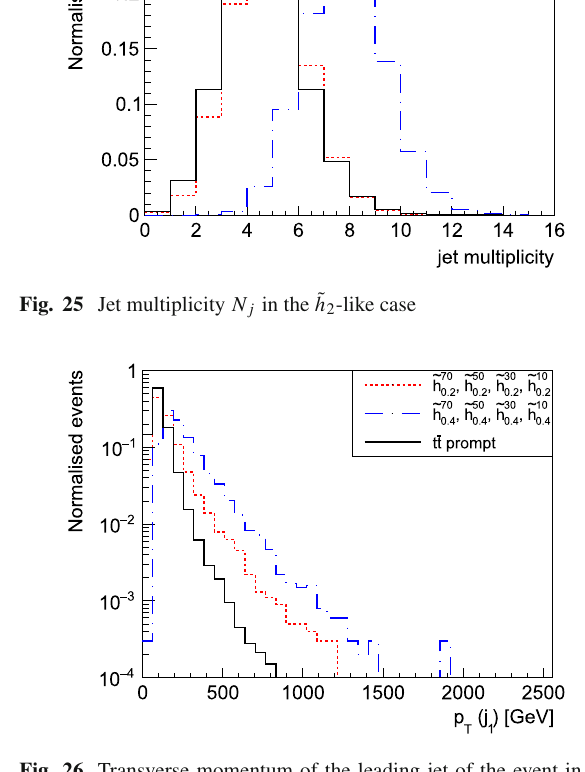
Fig. 26 Transverse momentum of the leading jet of the event in the ˜ h 2 -like